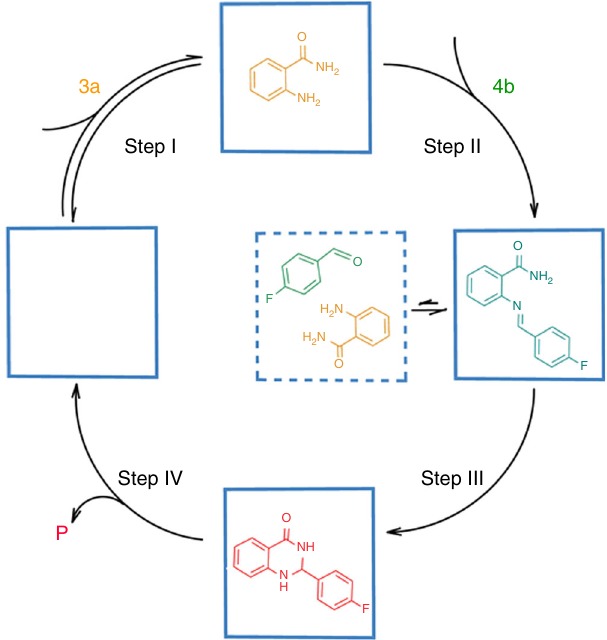
Fig. 5 Representation of the sequential condensation and cyclization of anthranilamide with aldehyde in the cage (the square represents the cage; 3a and 4b stand for the substrates and P stands for the